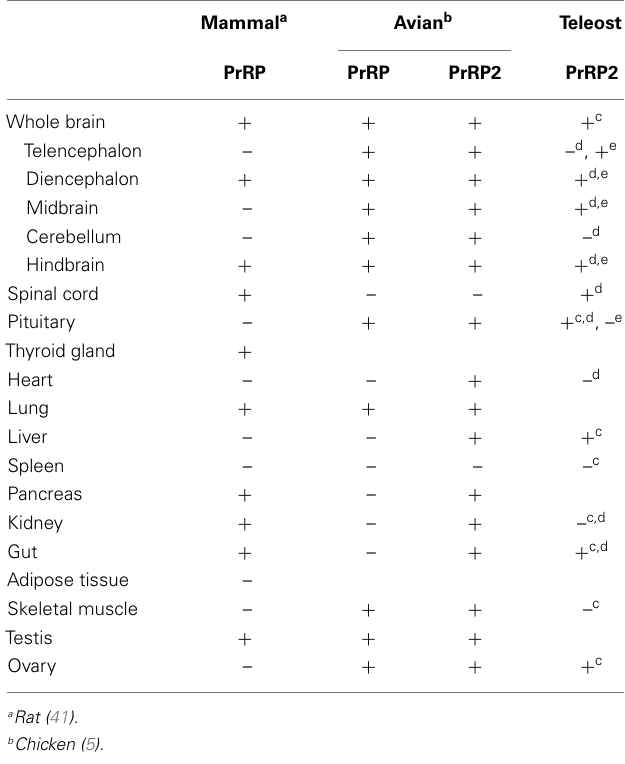
Table 1 | Comparison of the distribution of PrRP and PrRP2 mRNA among mammals, avians, and teleosts